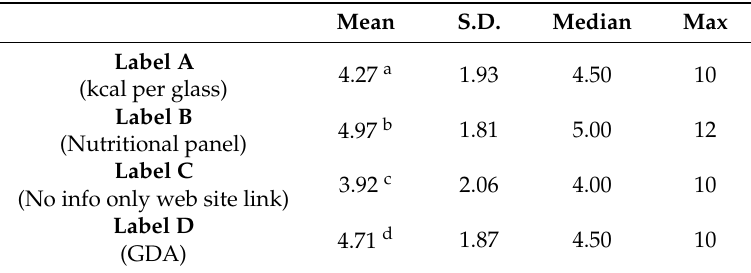
Table 4. WTP for wine label formats ( €